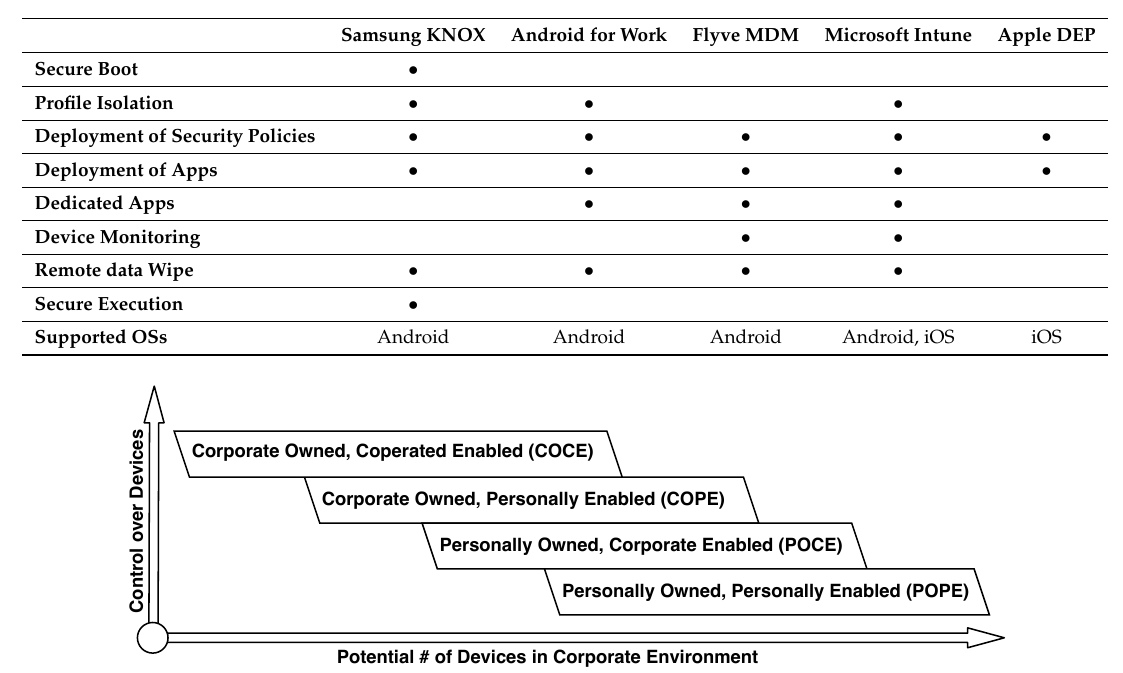
Table 1. Security-related features of Mobile Device and Application Management (MDAM) frameworks.